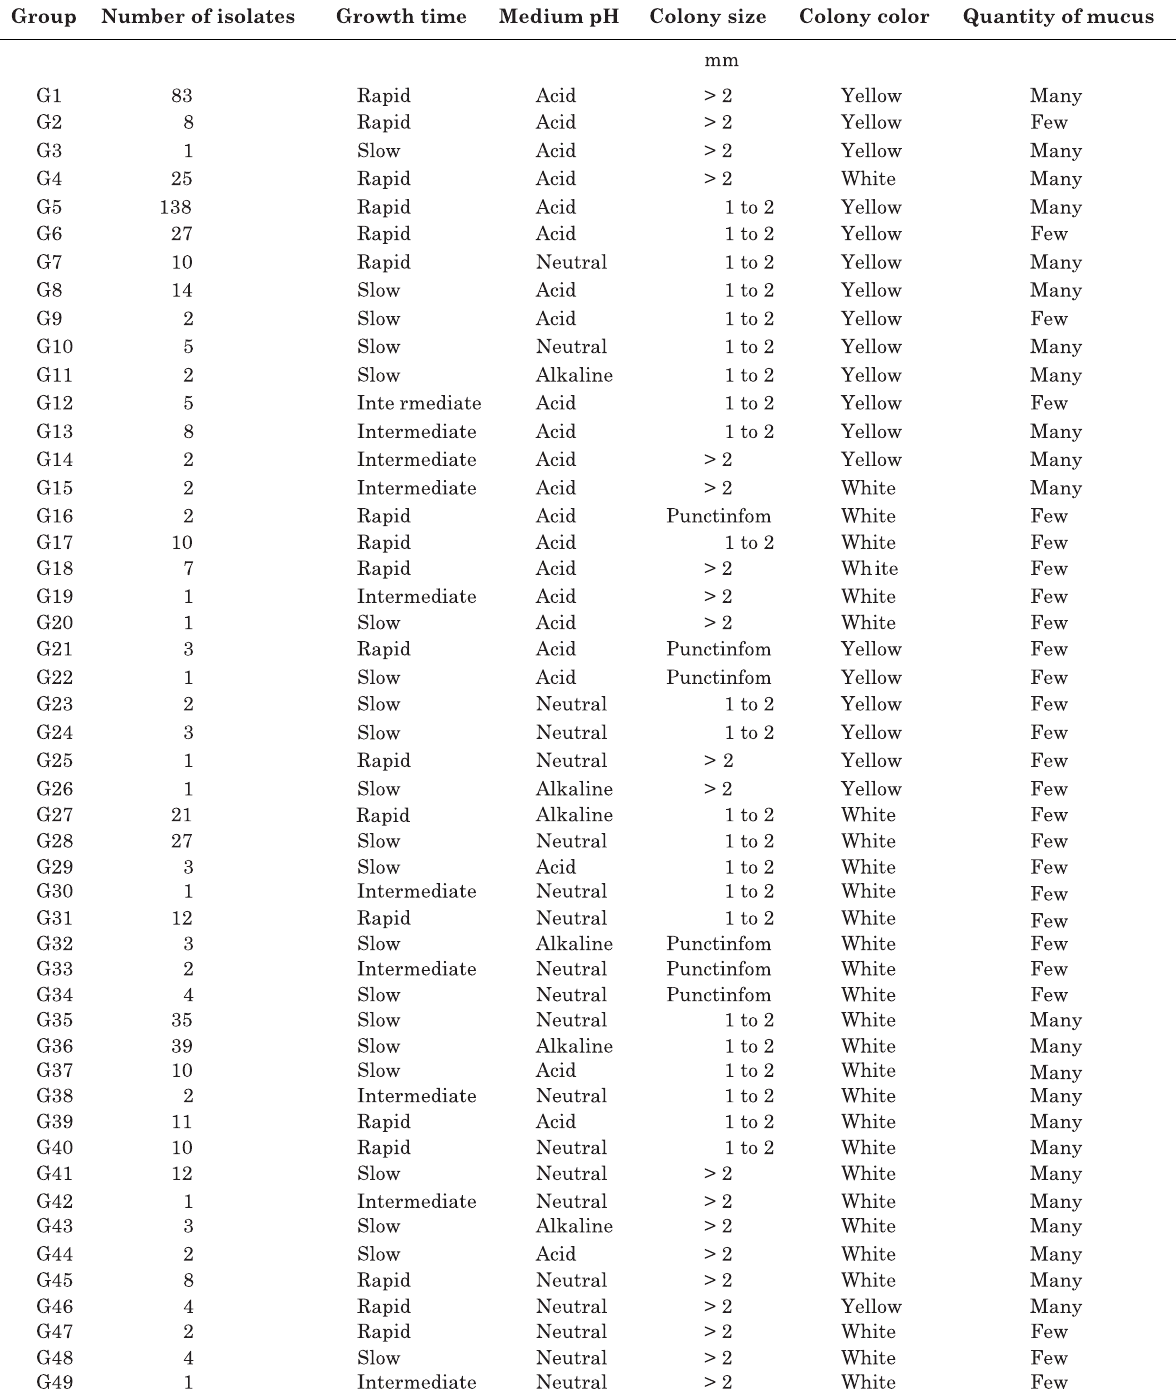
Table 5. Morphological groups based on the rhizobium characteristics growth speed, pH in the culture medium, size and color of the colony and the quantity of mucus of cowpea rhizobium isolates grown in soils of the lower half of the São Francisco river